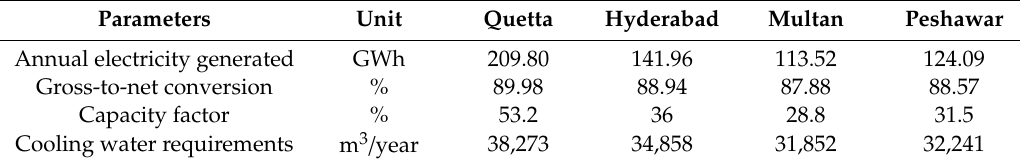
Table 9. Performance parameters of the 50 MWe SPT plant with air